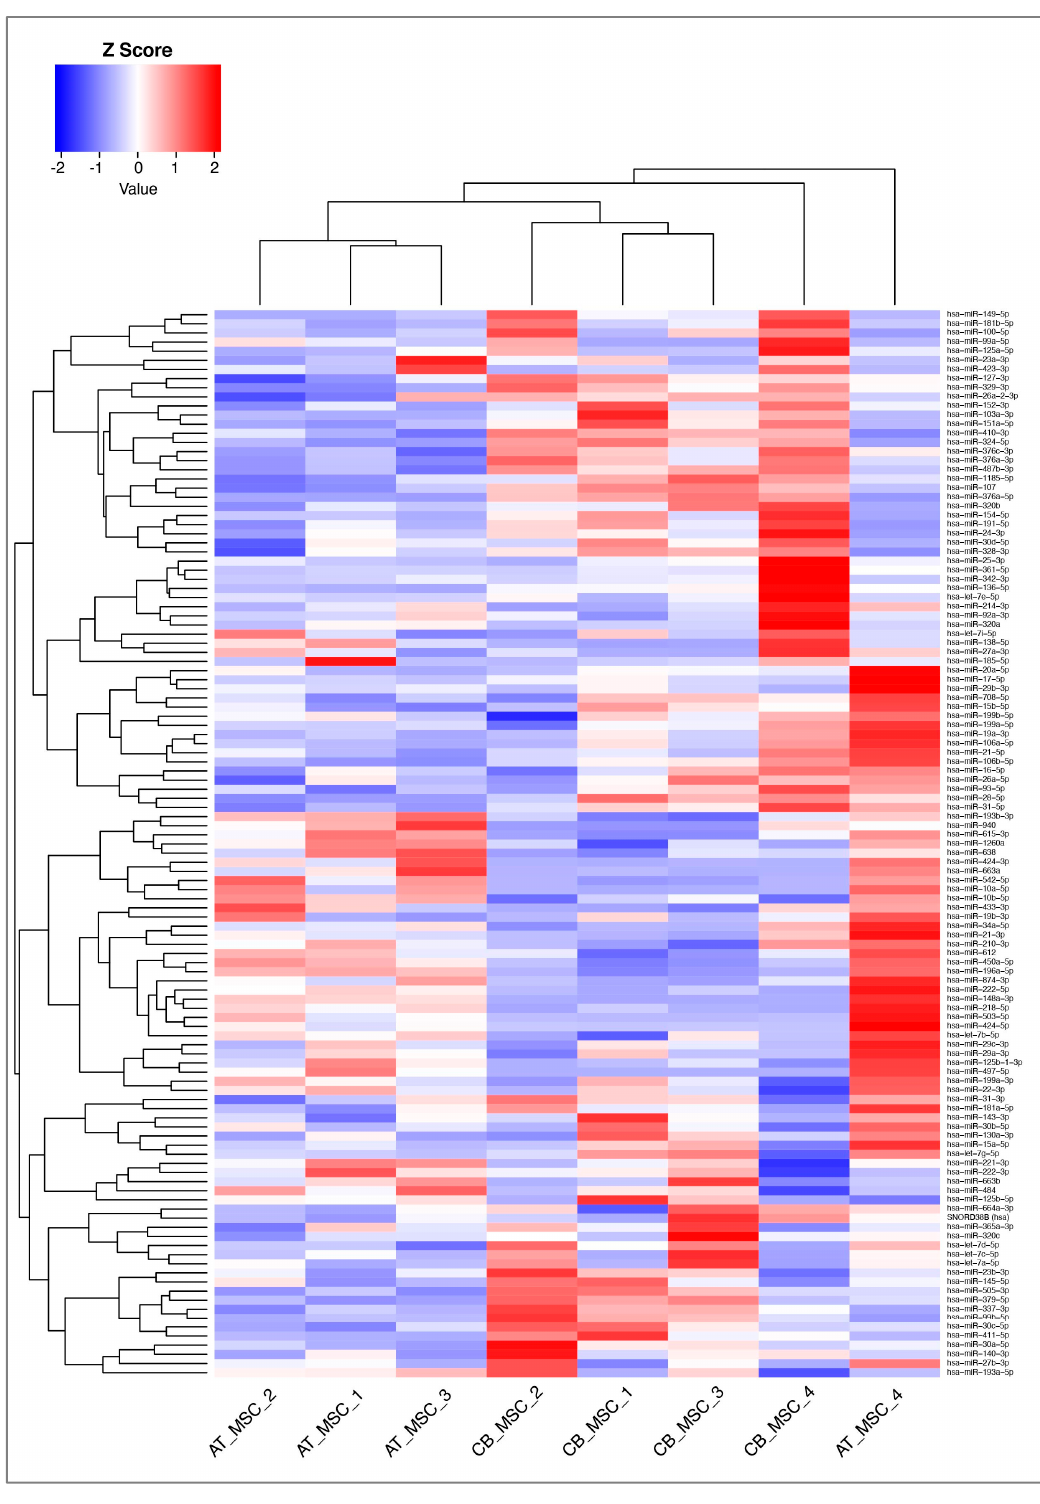
Figure 5. Heatmap and dendrograms of all microRNAs (miRNAs) detected with certainty according to the guidelines of the Qiagen-Exiqon miRCURY LNA Universal RT microRNA PCR system. Sample IDs are shown on the x-axis. Samples with similar miRNA expression are clustered together. The heatmap was generated by RStudio and 2 dCT was used for data input. Z-scores of more than zero indicate a higher expression of miRNAs in one sample compared to the others; Z-scores of less than zero indicate the